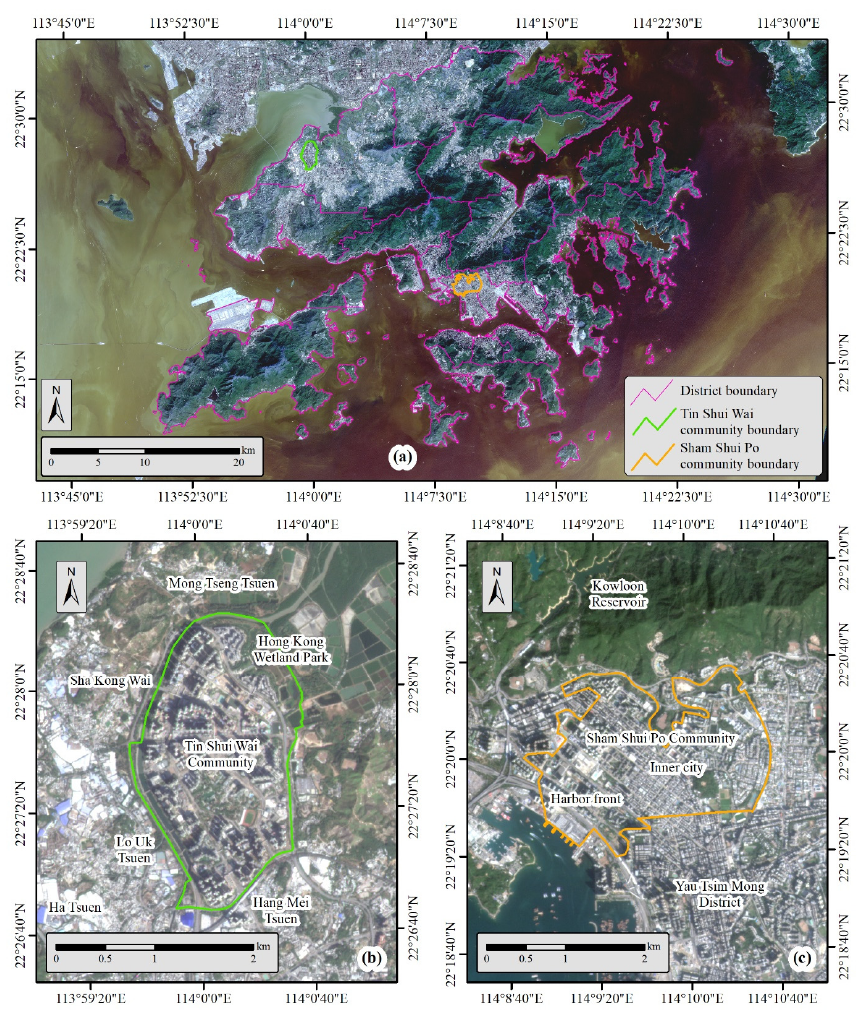
Figure 1. The geographic settings of SSP and TSW. ( a ). The locations of SSP and TSW in Hong Kong, ( b ). the geographic settings of TSW (new town), and ( c ). the geographic settings of SSP (old town). Communities in Hong Kong are mainly old towns developed in earlier times and new towns developed since the 1950s. Old towns and new towns represent two geographic contexts with considerable differences in building density, urban planning, traffic networks, etc. [31]. SSP is chosen to represent the old towns in Hong Kong. It is a densely populated community, and the blocks included in this study have a total area of 5.35 km 2 , with a residential population of about 300,000 in 2018. On the other hand, TSW is chosen to represent the new towns in Hong Kong. It has a total area of 4.32 km 2 and its residential population was also about 300,000 in 2018. SSP and TSW can well represent the geographic contexts of old towns and new towns in Hong Kong (Figure 1b,c). SSP belongs to the downtown area of Hong Kong, which is among the earliest-developed urban areas